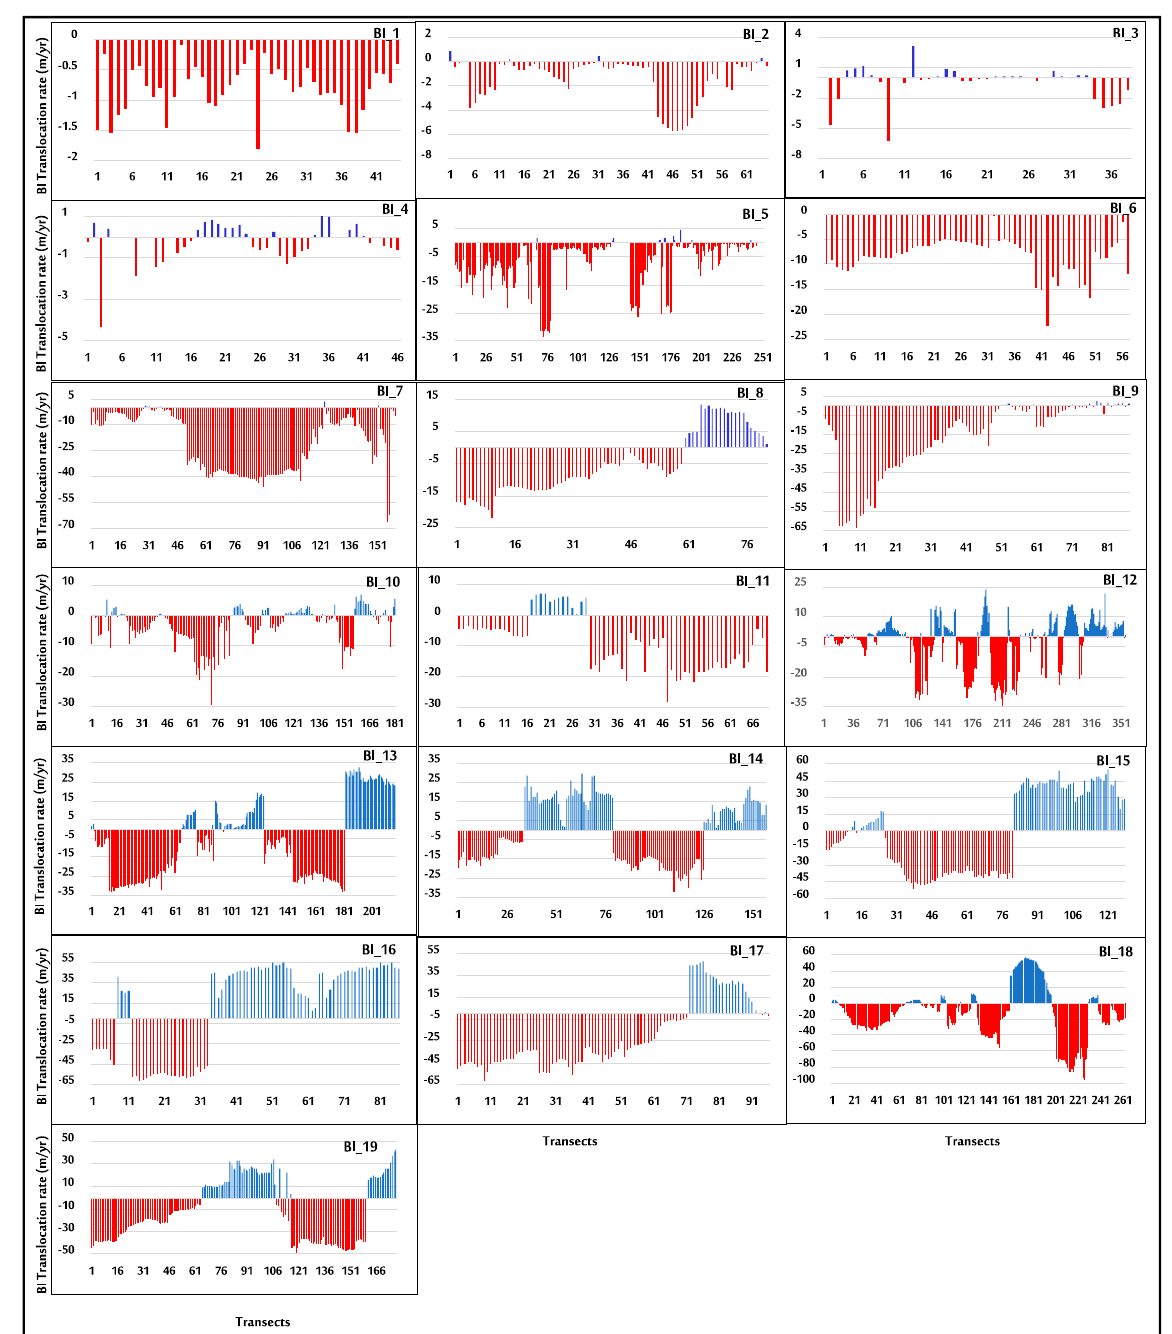
Figure 5. BI-wise erosion and accretion at each transect in the study area. For simplification, the linear regression rate (LRR, m/y) for both the seaside and landside transects are combined and presented together for each BI. For the majority of BIs, the number of eroding transects exceeds the number of accreting transects. These plots do not include those transects which do not intersect all the four shorelines, and output was NULL.